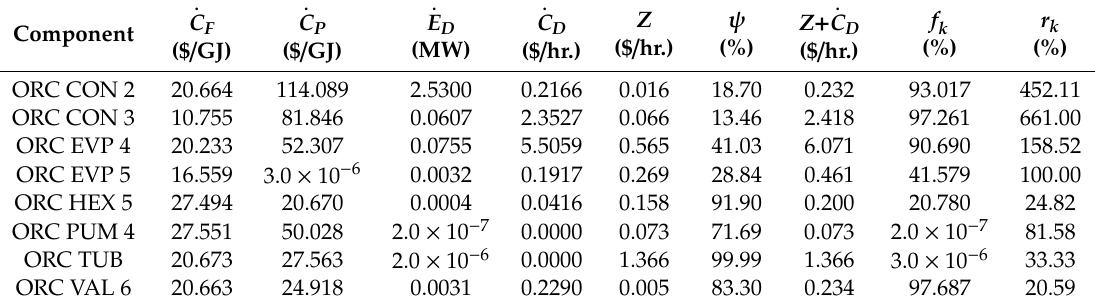
Table 9. Exergoeconomic parameters for the ORC power cooling cycle.